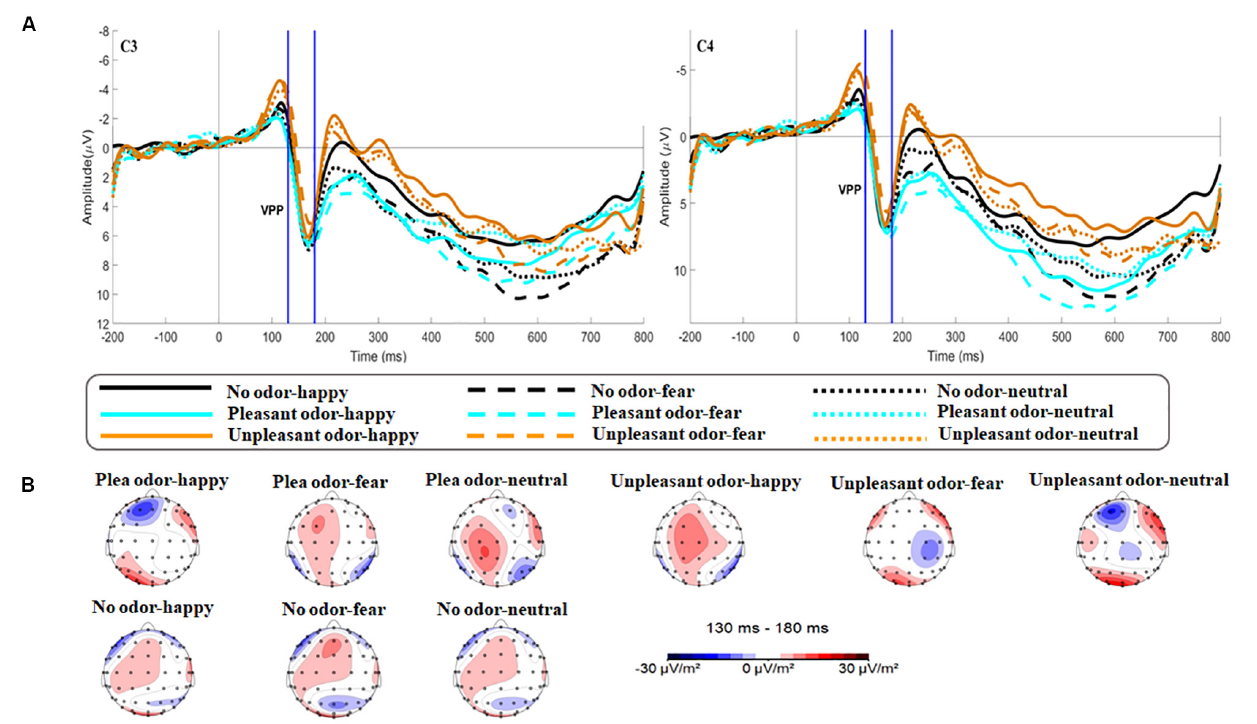
FIGURE 6 | The amplitude and topography for VPP for each odor-face condition. (A) Interaction of expression and odor context at electrodes C3 and C4 for VPP. The area between the two blue dotted lines indicates the time window (130–180 ms) of the VPP component. (B) Brain topography of VPP for each odor-face condition.